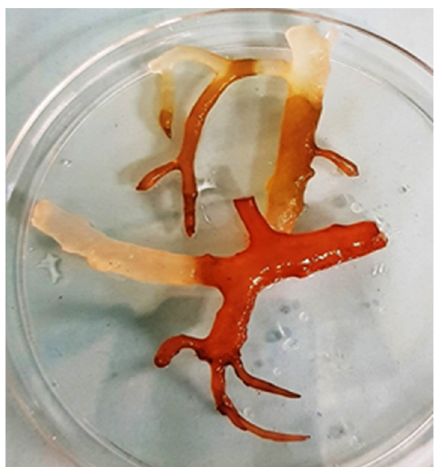
Figure 3. The presence of ice ‐ ice disease or bleaching on thalli tips of K. alvarezii from Kota Belud, Sabah.